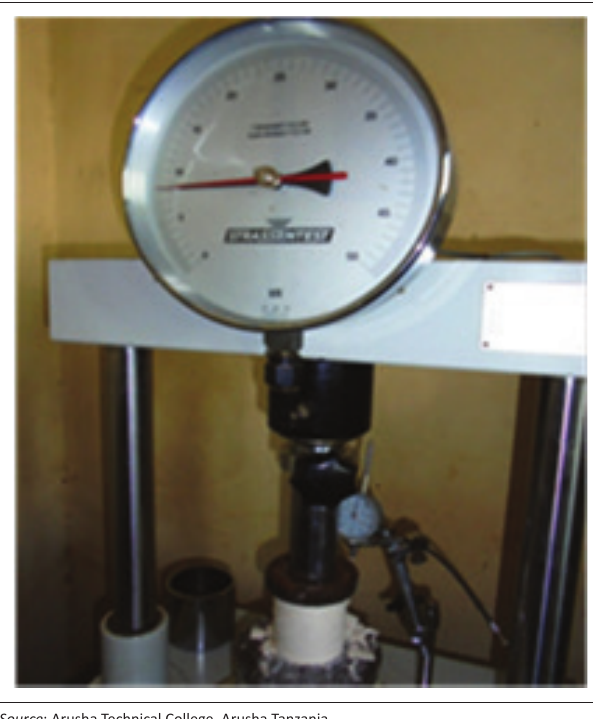
FIGURE 9: A Germany Universal Testing machine (UTM), or materials test frame, is used to test the tensile strength and compressive strength of materials.